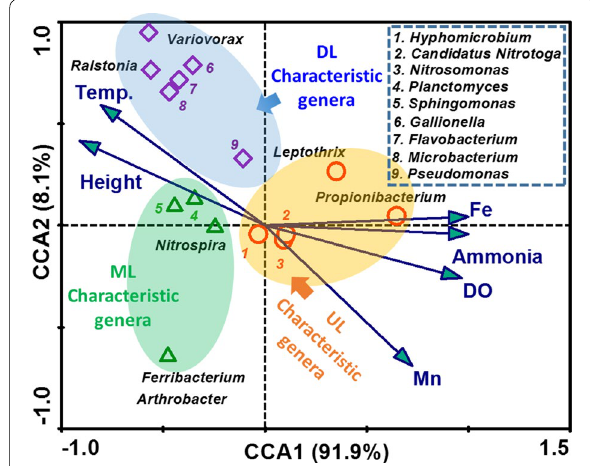
Fig. 4 Canonical correspondence analysis (CCA) between enriched genera and environmental variables (iron, manganese, ammonia, DO, temperature and layer